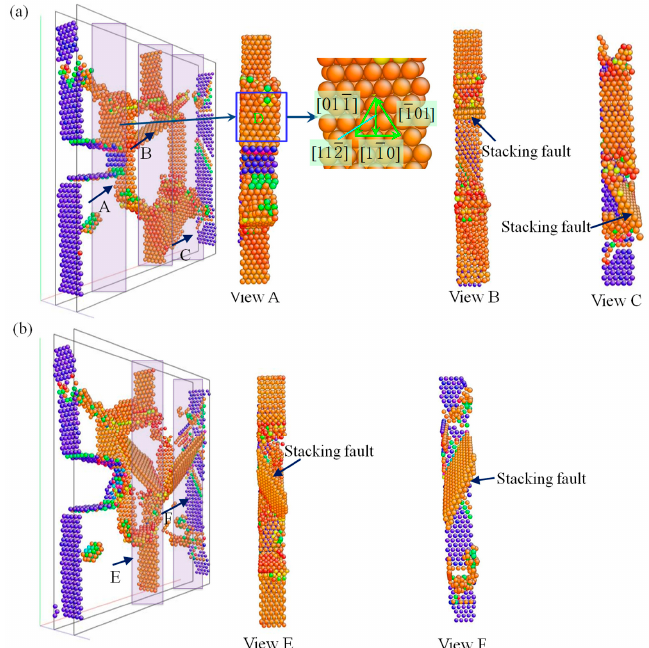
Figure 9. Detailed evolution of atomic configuration in nanoscale polycrystal nickel at the strain rate of 2 × 10 8 s − 1 : ( a ) ε = 0.096; ( b ) ε = 0.18. (All the configurations are characterized by CSP, where stacking faults are companied by Shockley partial dislocations).